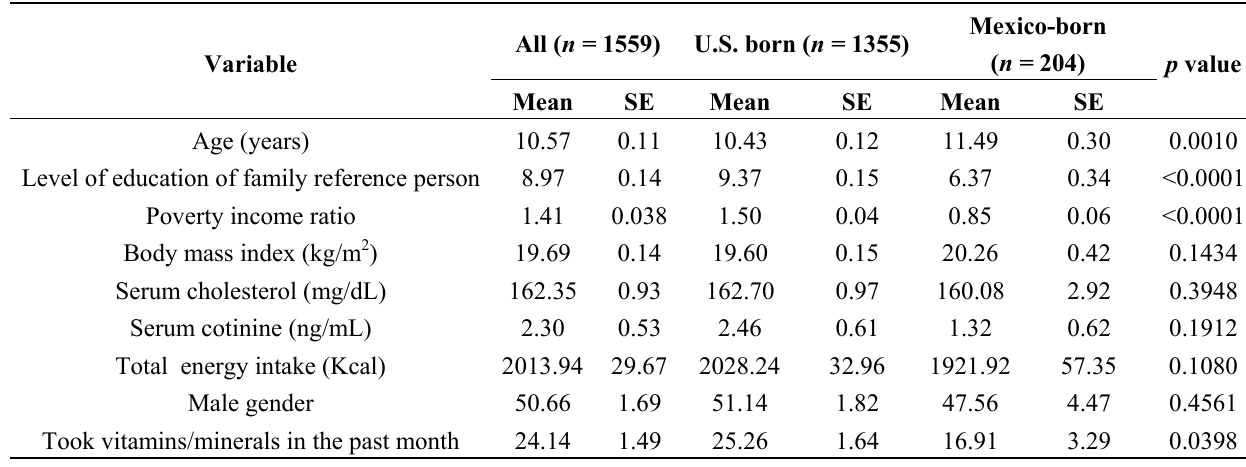
Table 1. Characteristics of the Study Population.